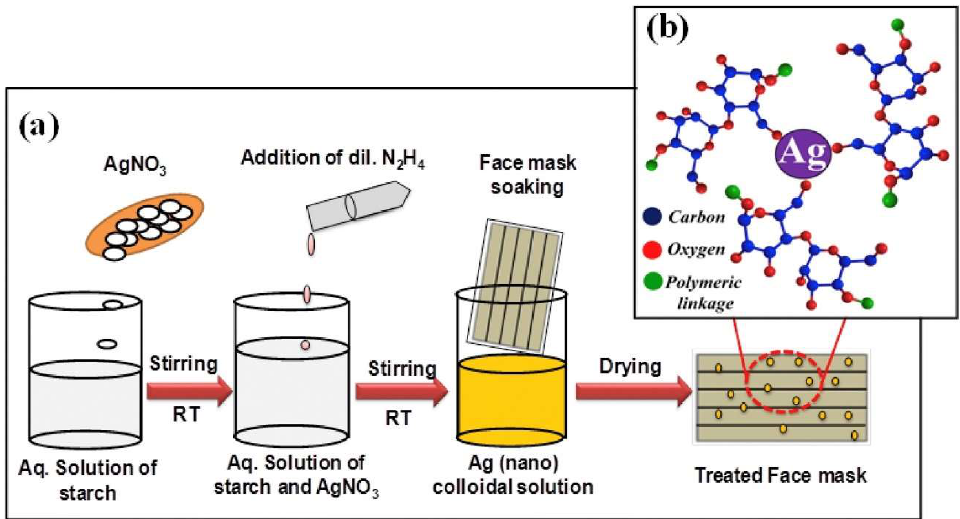
Figure 10. ( a ) Schematic representation of the synthesis of colloidal Ag (nano) solution and its treatment of face mask ( b ) starch capped Ag nanoparticles. Reproduced with permission from reference [99]. Copyright (2018), Elsevier .